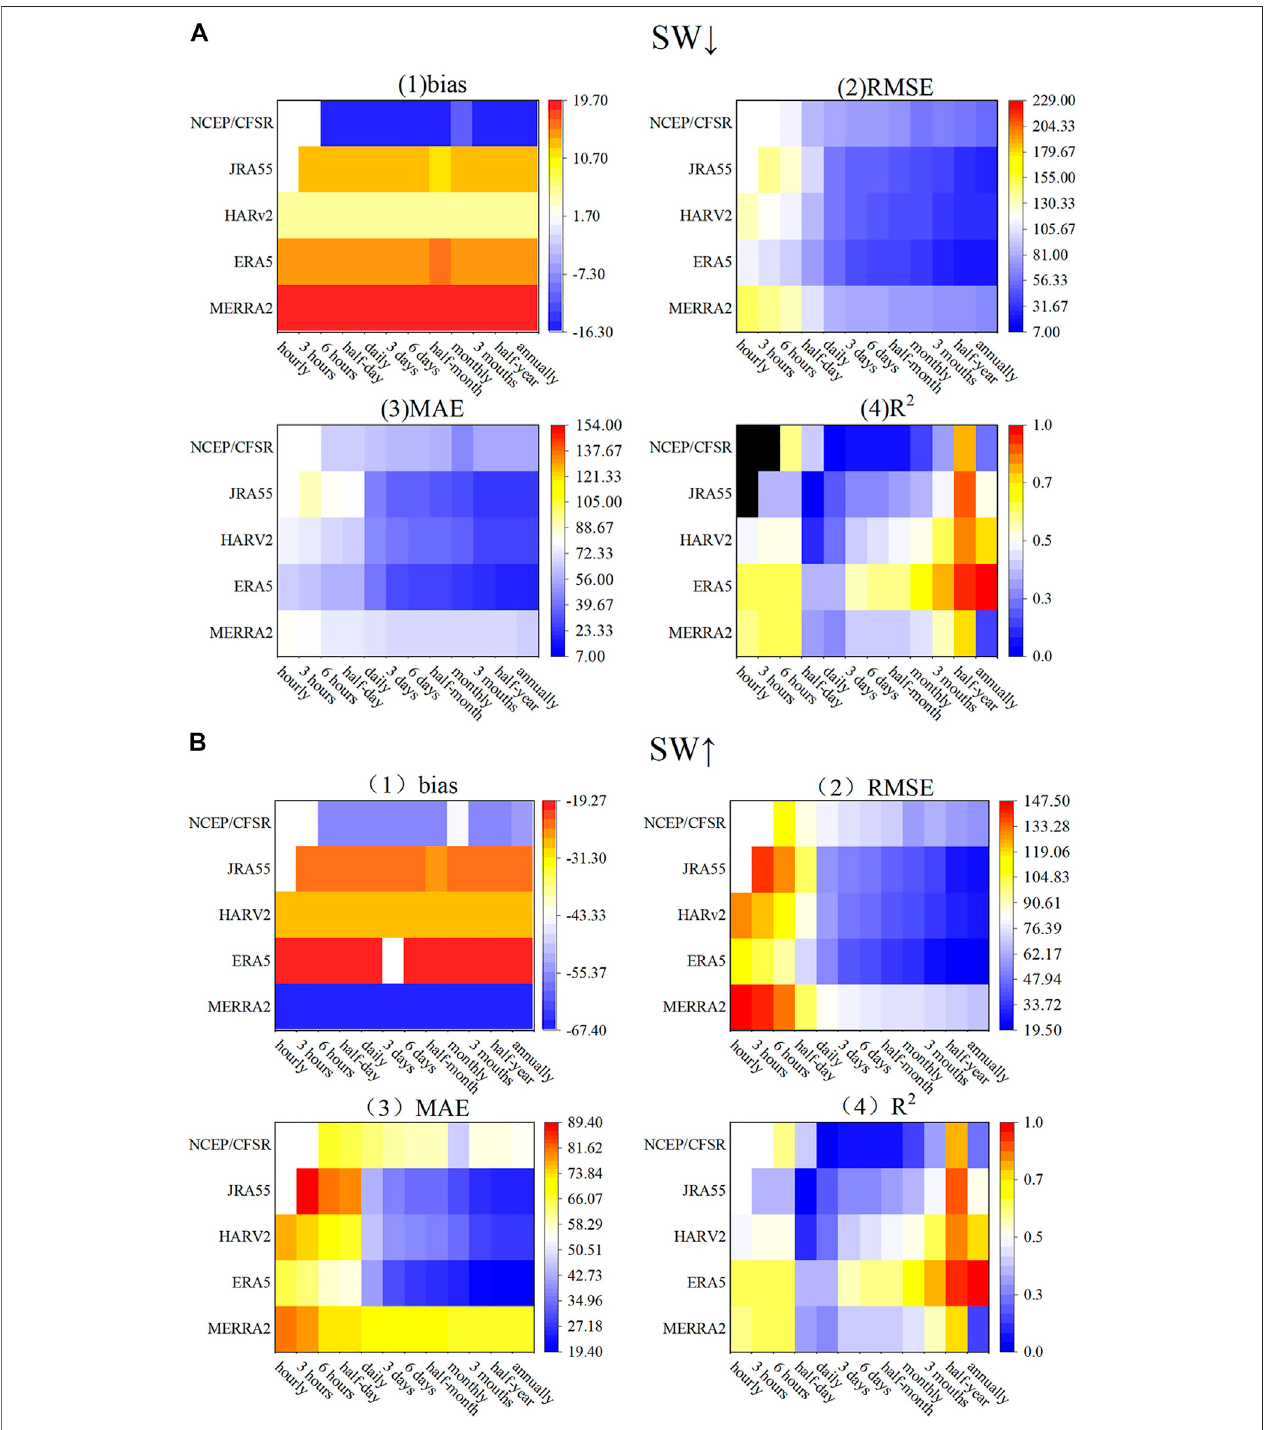
FIGURE 3 | Five sets of reanalysis datasets shortwave radiation evaluation results; (A) and (B) represent downward shortwave radiation and upward shortwave radiation, respectively.